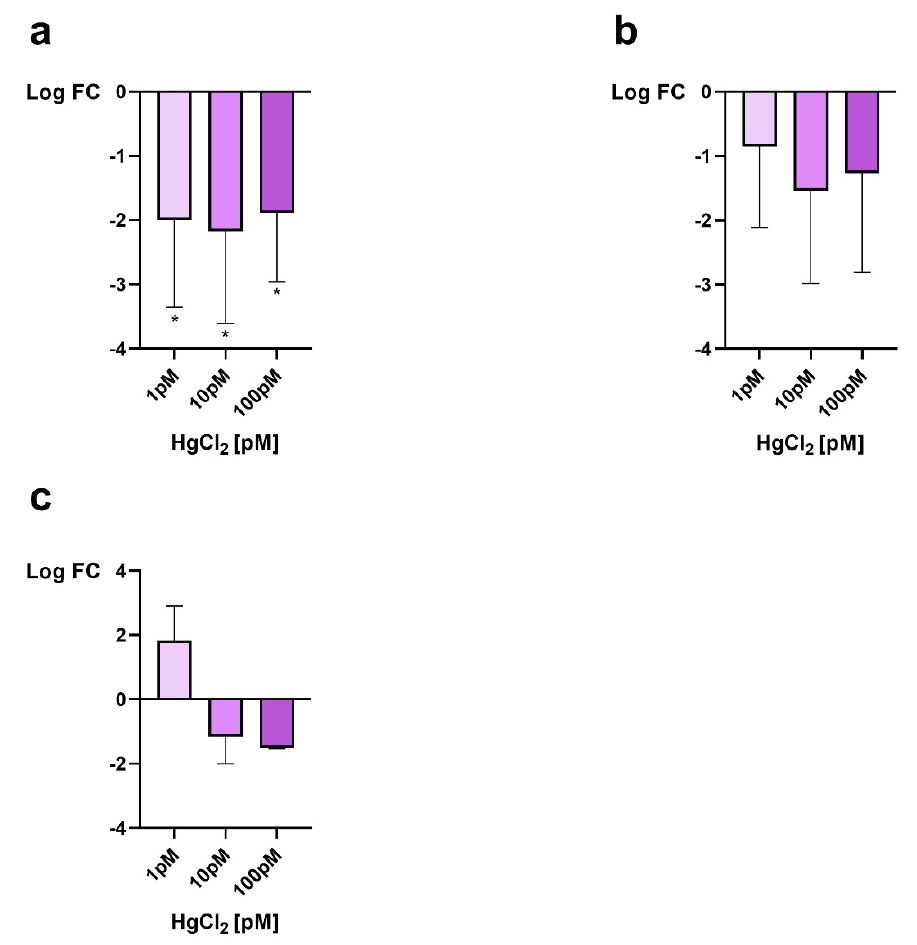
Figure 1. RT-qPCR expression analysis of M. galloprovincialis gonadal hsp70 , π gst and mt10 . In the figure, the change in expression, respect to the control condition (nonexposed mussels), of hsp70 ( a ), π gst ( b ) and mt10 ( c ) is reported under the three HgCl 2 exposure conditions. Expression was determined with respect to the GAPDH housekeeping gene. Values are presented as mean ± S.D. ( n = 6); asterisks indicate a statistically significant difference from unexposed mussels: * = p < 0.05.